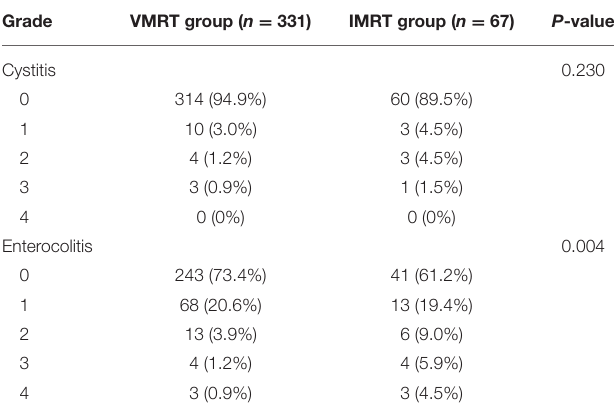
TABLE 5 | Chronic toxicities in patients with cervical